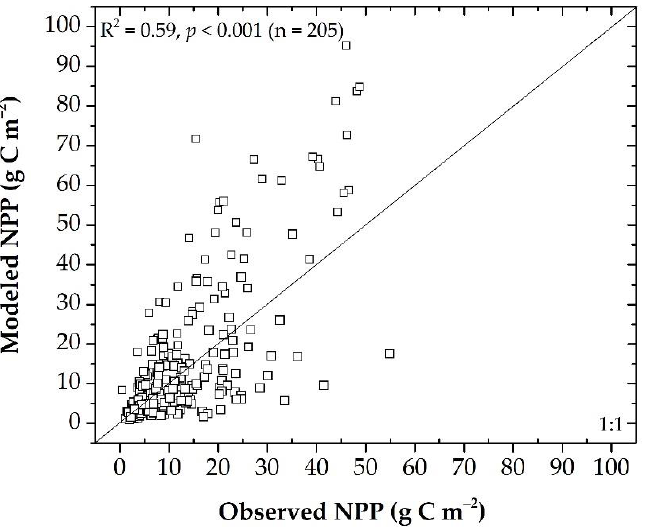
Figure 3. Validation of the NPP estimate at 205 observation sites across Mongolia (Nanzad et al. [10]). Each dot represents averaged NPP from 2003 to 2018.